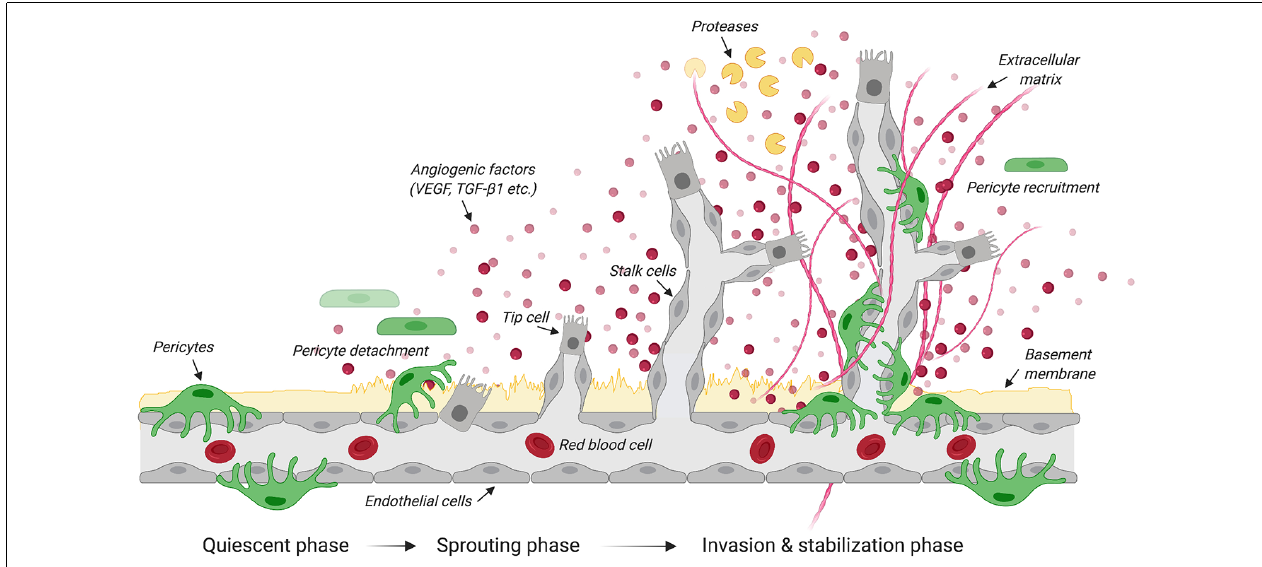
FIGURE 1 | Steps in angiogenesis. Schematic illustrates the quiescent, sprouting and invasion phases that characterize the growth of new blood vessels from the existing vasculature. Upon the release of angiogenic factors, receptor-ligand coupling activates endothelial cells that undergo migration and proliferation. The upregulation of protease expression allows the degradation of the basement membrane and pericyte detachment. Specialized endothelial cells called “tip cells” migrate along the angiogenic gradient where tubule formation is controlled by the Tie-2/angiopoietin axis. Another type of specialized endothelial cells called “stalk cells” proliferates to support the main body of the new vessel. By dissolving the extracellular matrix, proteases contribute to structural remodeling of the tubular network. Pericytes are then recruited to stabilize newly formed blood vessels. Created with biorender.com.